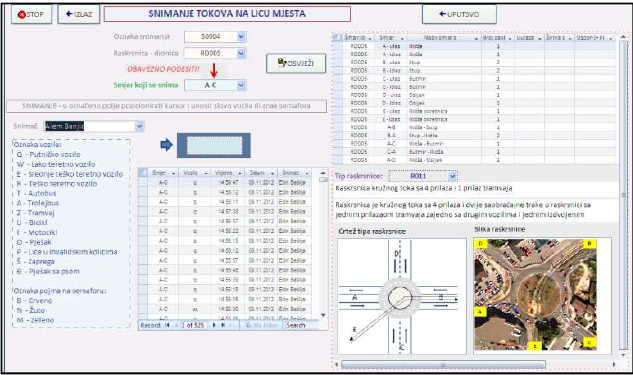
Figure 4. Form of program for research of flows at intersections and road